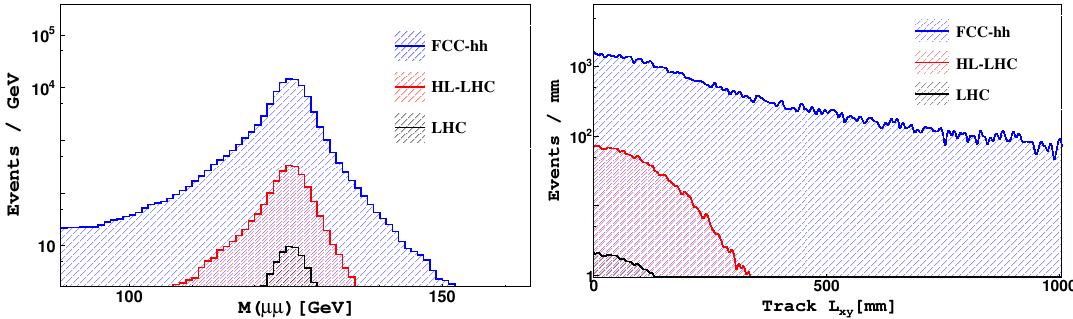
Figure 10 . Results from our simulations before applying any cuts. Left: invariant mass of H (cid:6)(cid:6) decaying to two muons (cid:12)nal state. Right: longitudinal length of H (cid:6)(cid:6) decaying to two